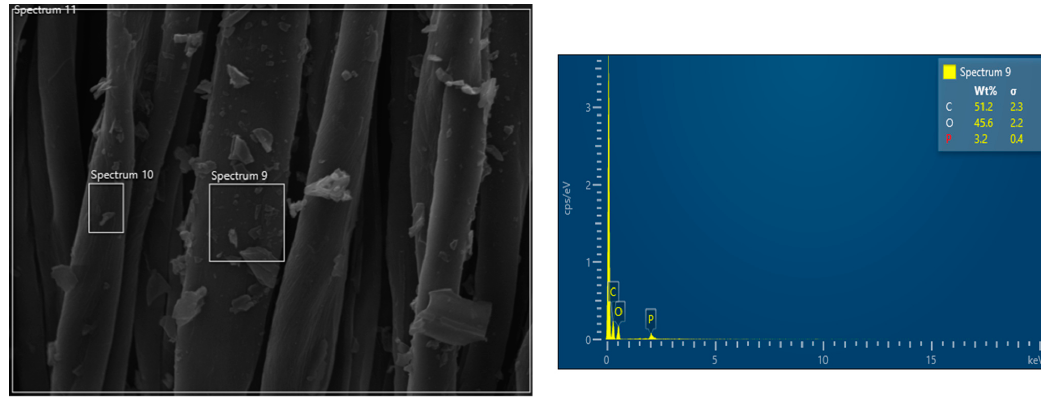
Figure 4. Energy dispersive X ‐ ray (EDX) mapping of COT+PA+BC(8).